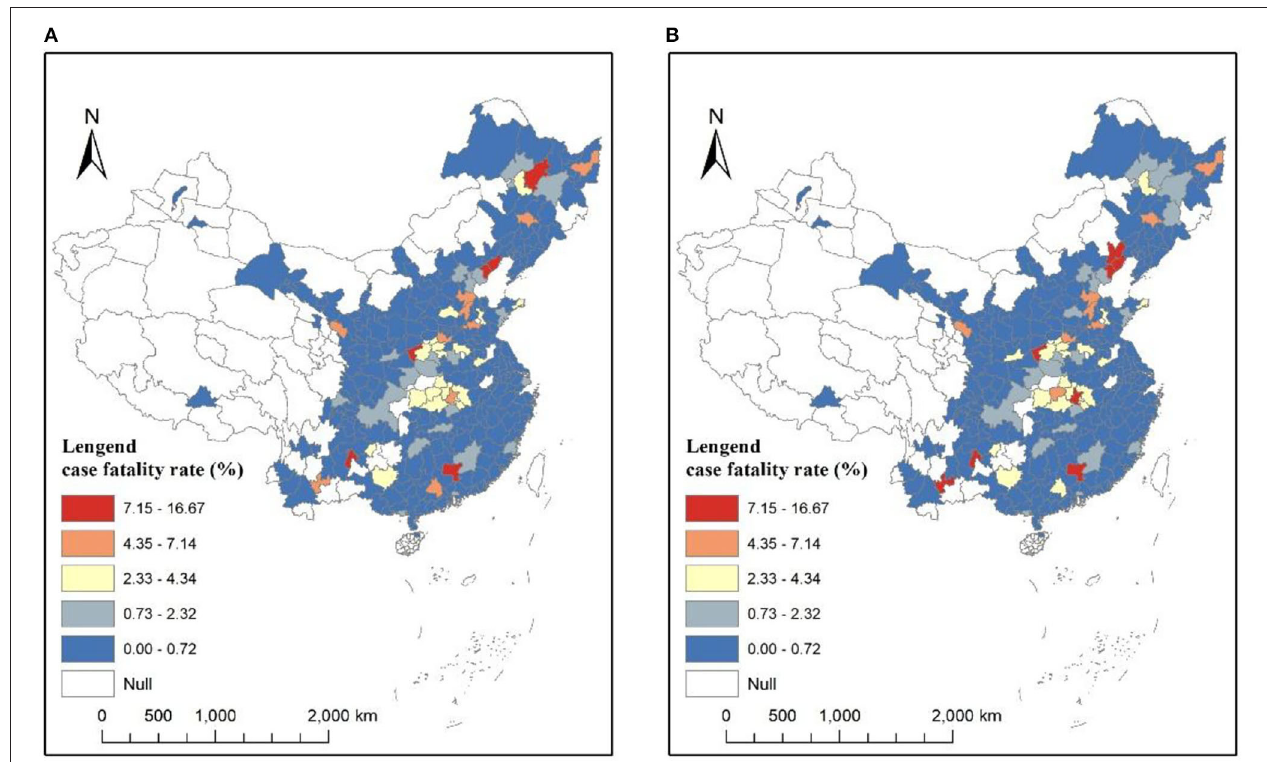
FIGURE 1 | Coronavirus disease 2019 (COVID-19) case fatality rates (CFRs) at the city level. (A) March 13, 2020. (B) January 25,